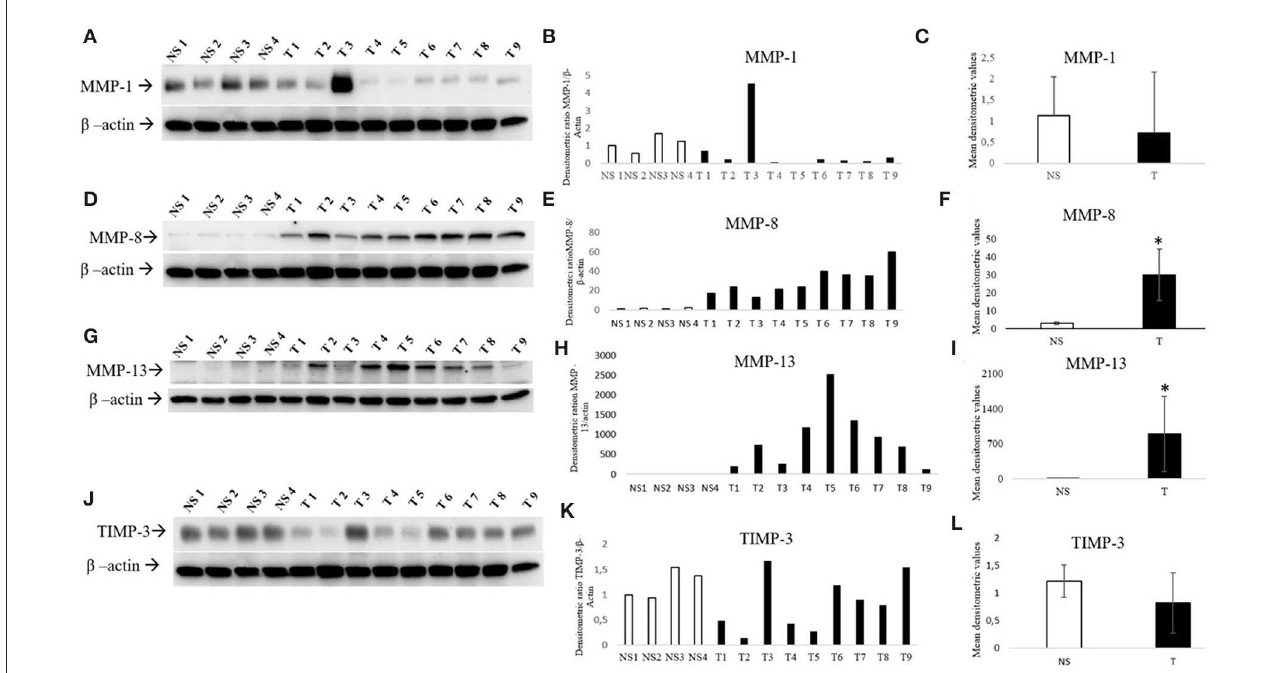
FIGURE3 Western blotting analysis of MMP-1/-8/-13 and TIMP-3 in bovine normal skin (NS) and fibropapillomas (T). Western blotting and densitometric measurements of MMP-1/-8/-13 and TIMP-3 in NS1-NS4 and T1-T9 samples (A–L) . Representative gels showing an enhanced amount of MMP-8/-13 (D, G) and decreased expression of MMP-1 (A) and TIMP-3 (J) in tumor compared with normal skin samples are shown. The blots were stripped and reprobed with anti- β -actin antibody to confirm comparable loading of proteins in each lane and allow normalization. (B, E, H, K) Individual densitometric values of MMP-1/-8/-13/ and TIMP-3 for each sample expressed as densitometric ratio with β -actin. (C, F, I, L) Mean densitometric values + /- standard deviations for MMP-1/-8/-13 and TIMP-3 in NS vs. T groups (*: statistically significant by t -test, P <